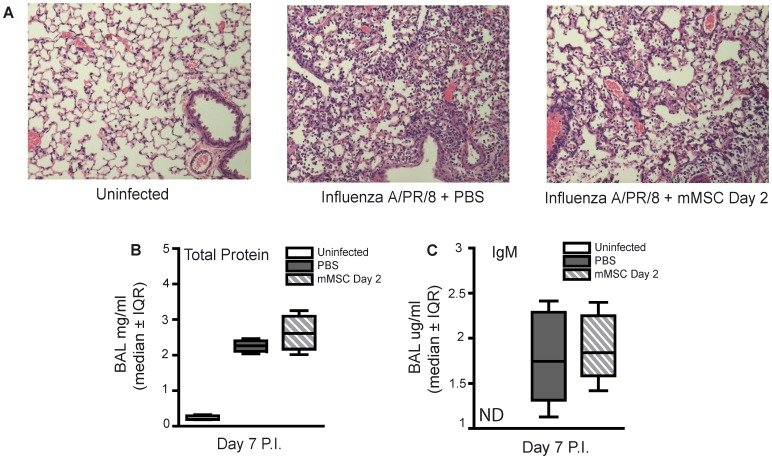
Therapeutic administration of mMSCs failed to modify pulmonary inflammation or alter acute lung injury in experimental severe influenza.Eight week old male C57Bl/6 mice were infected with 425 EID50 influenza A/PR/8 virus and administered 2.5×105 mMSCs (passage 6), via the tail vein, on day 2 P.I. Mice were sacrificed on day 7 P.I. (A) Representative images of hematoxylin and eosin stained lung sections demonstrate similar cellularity and lung injury in mMSC treated mice compared to infected controls. (B,C) No significant difference in BAL fluid markers of ALI (total protein or IgM) was observed between mice administered mMSCs and infected control mice administered PBS (one-way ANOVA, n = 6/group, representative of 2 independent experiments). Error bars represent interquartile range (IQR). ND = nondetectable.